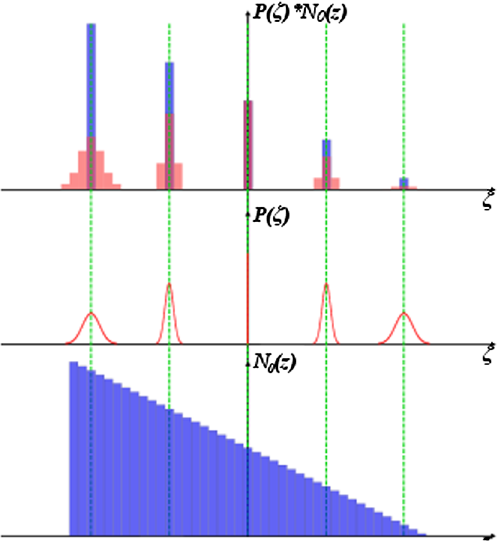
FIG. 14. The z 2 0 -series perturbation for the case of C 4 < 0 . Bottom: The ideal n 0 ð z i f Þ profile. Middle: The perturbation function P ð ζ Þ . Top: Slices of the ideal profile n 0 ð z i f Þ (blue) and the perturbed profile n ð z p f Þ (red). The shift is a skewed Gaussian towards the back of the bunch.